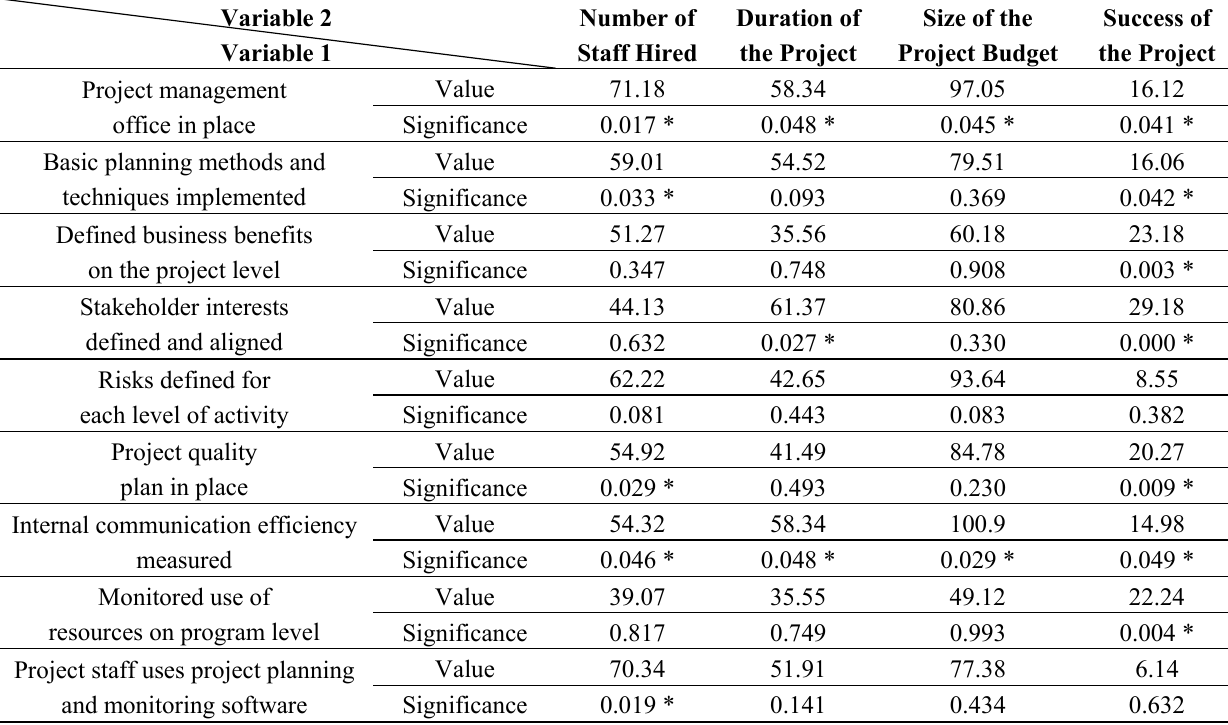
Table 1. Analysis of dependencies between variables using Chi-squared test.